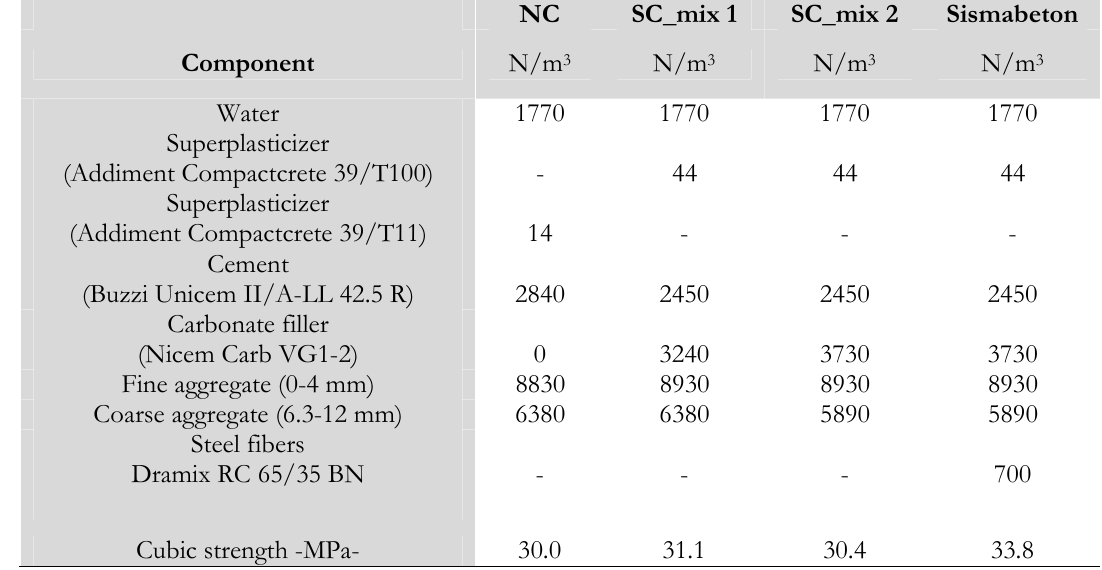
Table 1: Compositions and strengths of NC, SC_mix1, SC_mix2, and